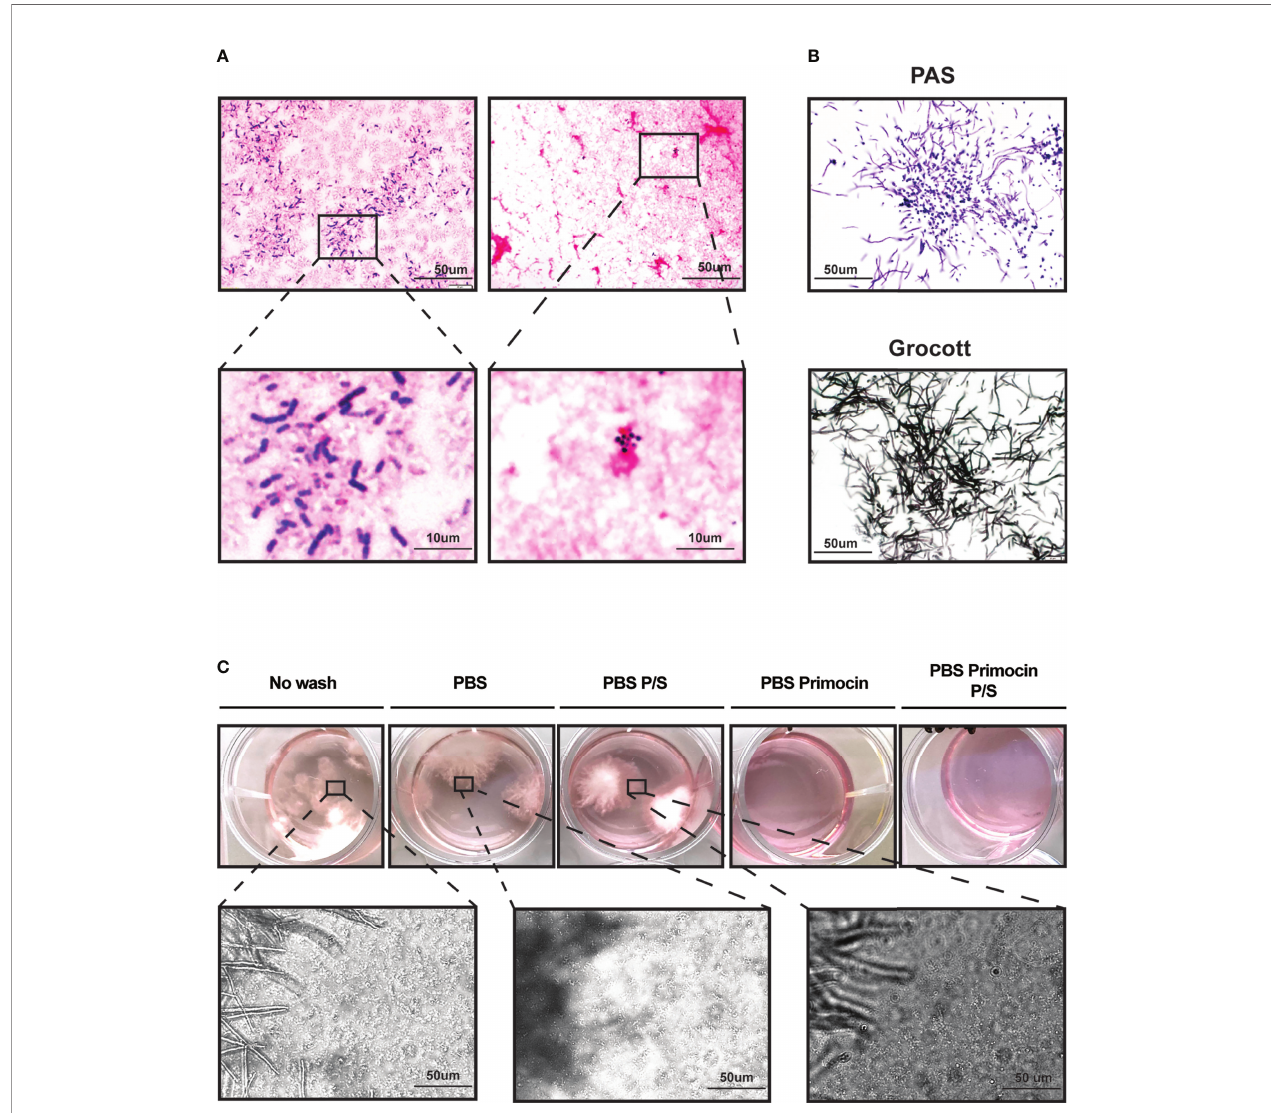
FIGURE 5 | Inappropriate washing conditions lead to GRAM-positive bacteria and Candida albicans contamination of PDO culture. (A) Representative micrographs showing PDO cultures contaminated with GRAM-positive bacteria. (B) Yeast, hyphae, and pseudohyphae structures are attributable to Candida albicans . (C) Micrographs show simultaneous contamination of both fungi and